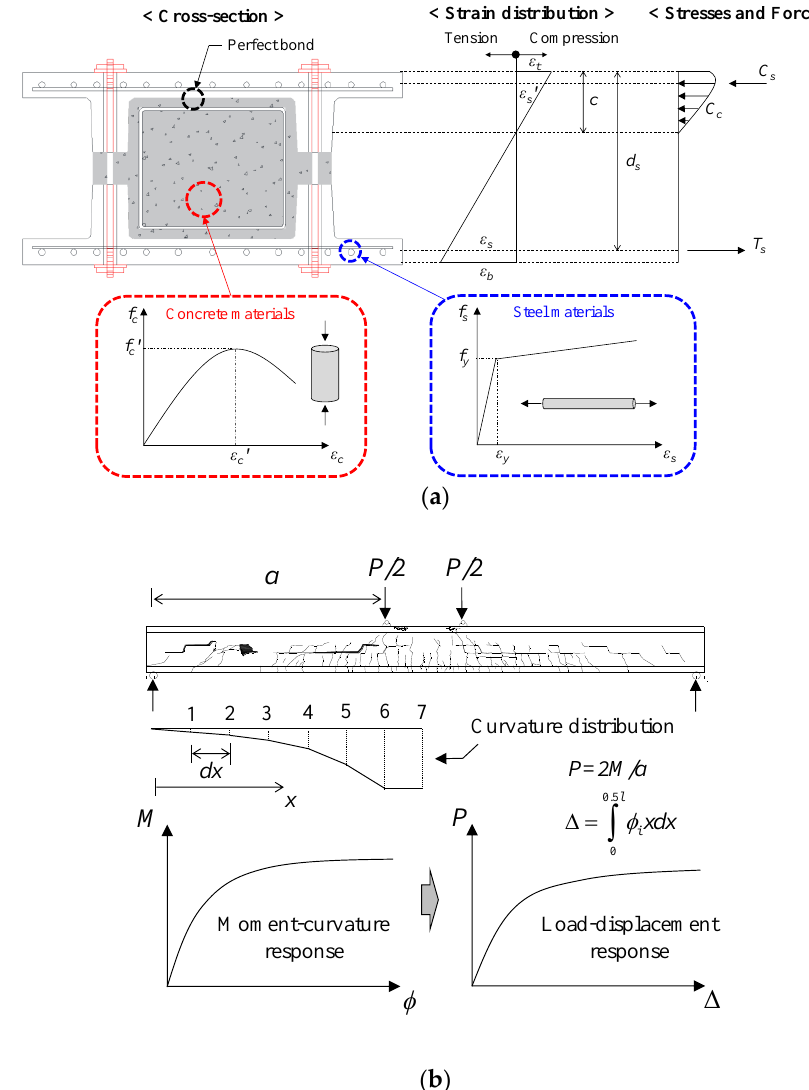
Figure 9. Nonlinear flexural analysis model: ( a ) schematic description of flexural analysis; ( b ) numerical integration for obtaining displacement.